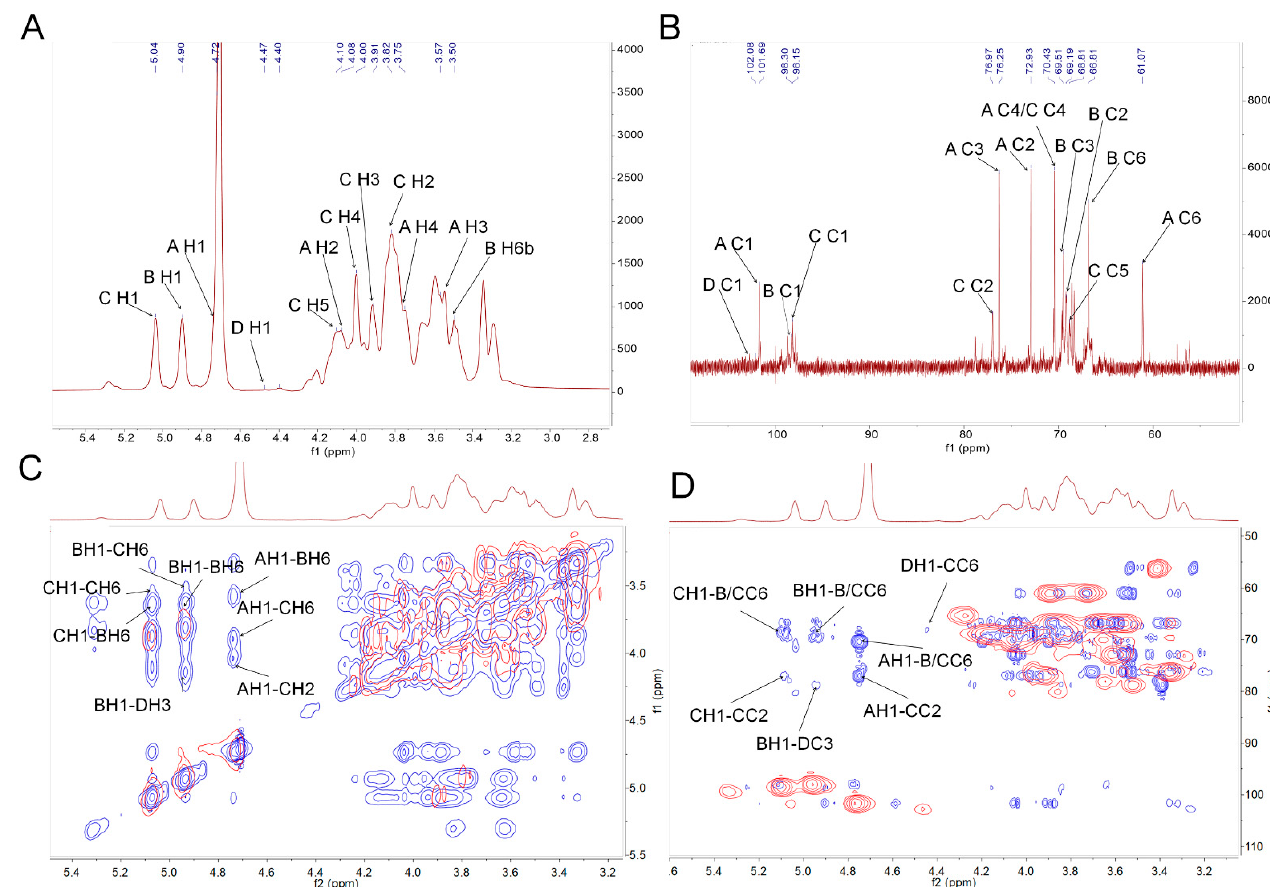
Figure 2. Structural characterization of PAPS1. One-dimensional NMR atlas of ( A ) 1 H, ( B ) 13 C NMR, and overlapped two-dimensional NMR atlas of ( C ) 1 H- 1 H COSY (red) and 1 H- 1 H NOESY (blue) (COSY-NOESY) and ( D ) HSQC (red) and HMBC (blue) (HSQC-HMBC). PAPS1, water-soluble PA polysaccharides, NMR, Nuclear magnetic resonance; COSY, correlation spectroscopy; NOESY, nuclear overhauser effect spectroscopy; COSY-NOESY, the picture of COSY and NOESY overlapped in the same figure; HSQC, heteronuclear single quantum correlation; HMBC, heteronuclear multiple bond correlation; HSQC-HMBC, the picture of HSQC and HMBC overlapped in the same figure. According to the literature reports and combined with the results above, the 1 H and 13 C chemical shift signals of the residues were assigned, and the results are shown in Table